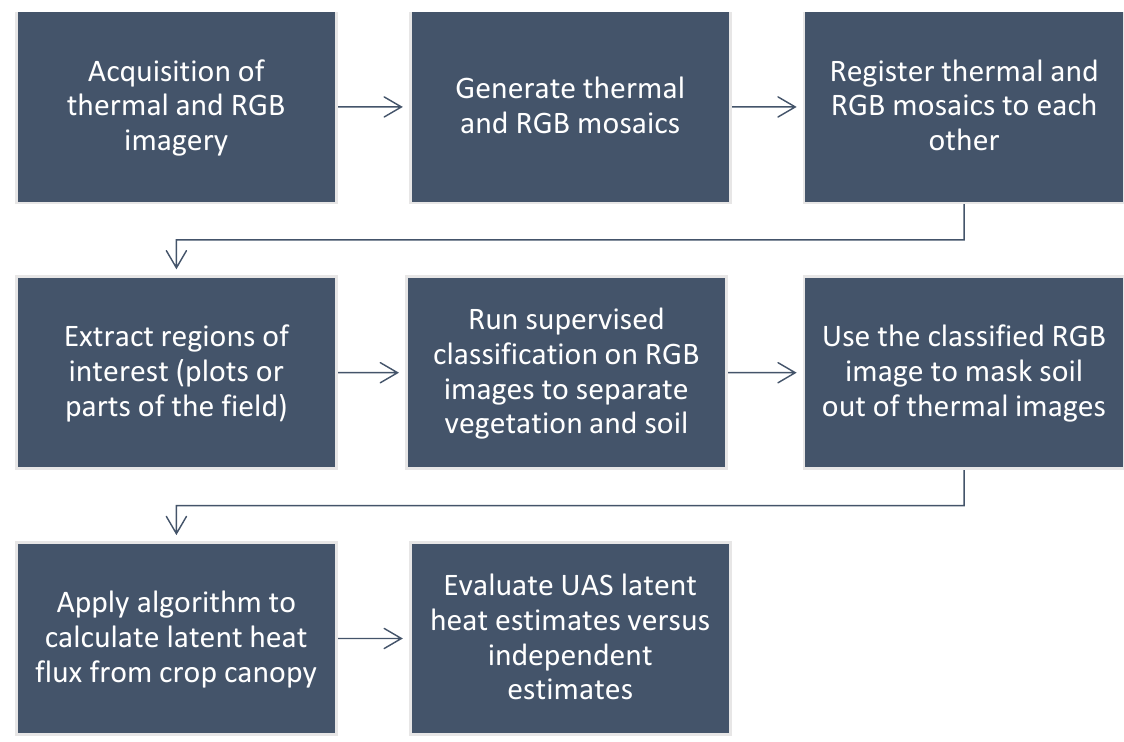
Figure 3. Latent heat flux calculations workflow.